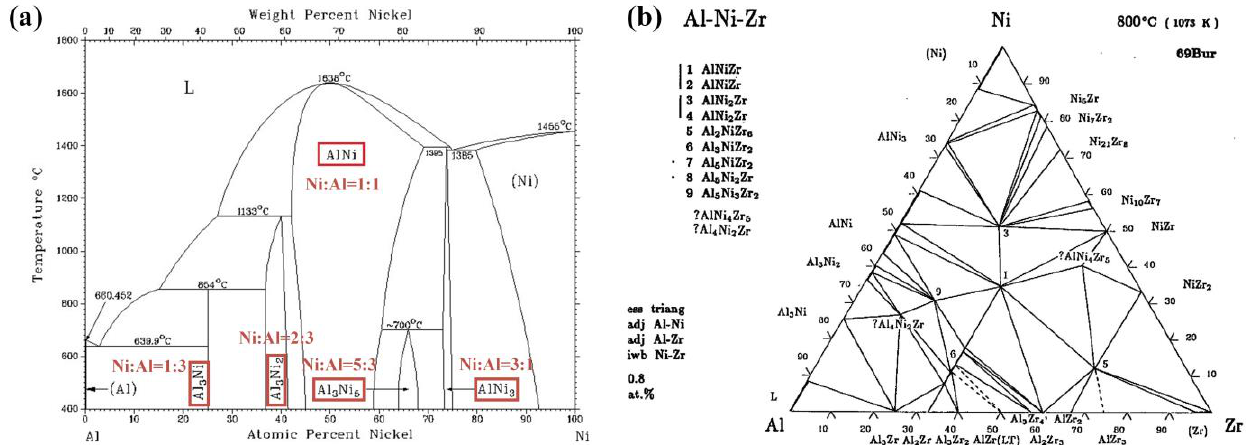
Figure 4. ( a ) Ni–Al phase diagram; ( b ) Ni–Al–Zr ternary phase Figure 4. ( a ) Ni – Al phase diagram; ( b ) Ni – Al – Zr ternary phase diagram.